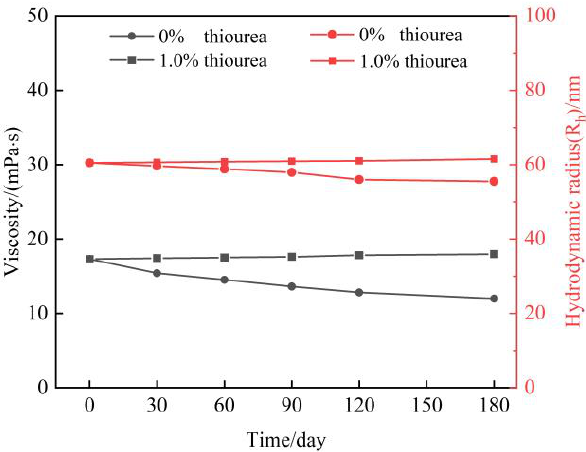
Figure 1. Properties of HPAM with the addition of thiourea in high pressure of flue